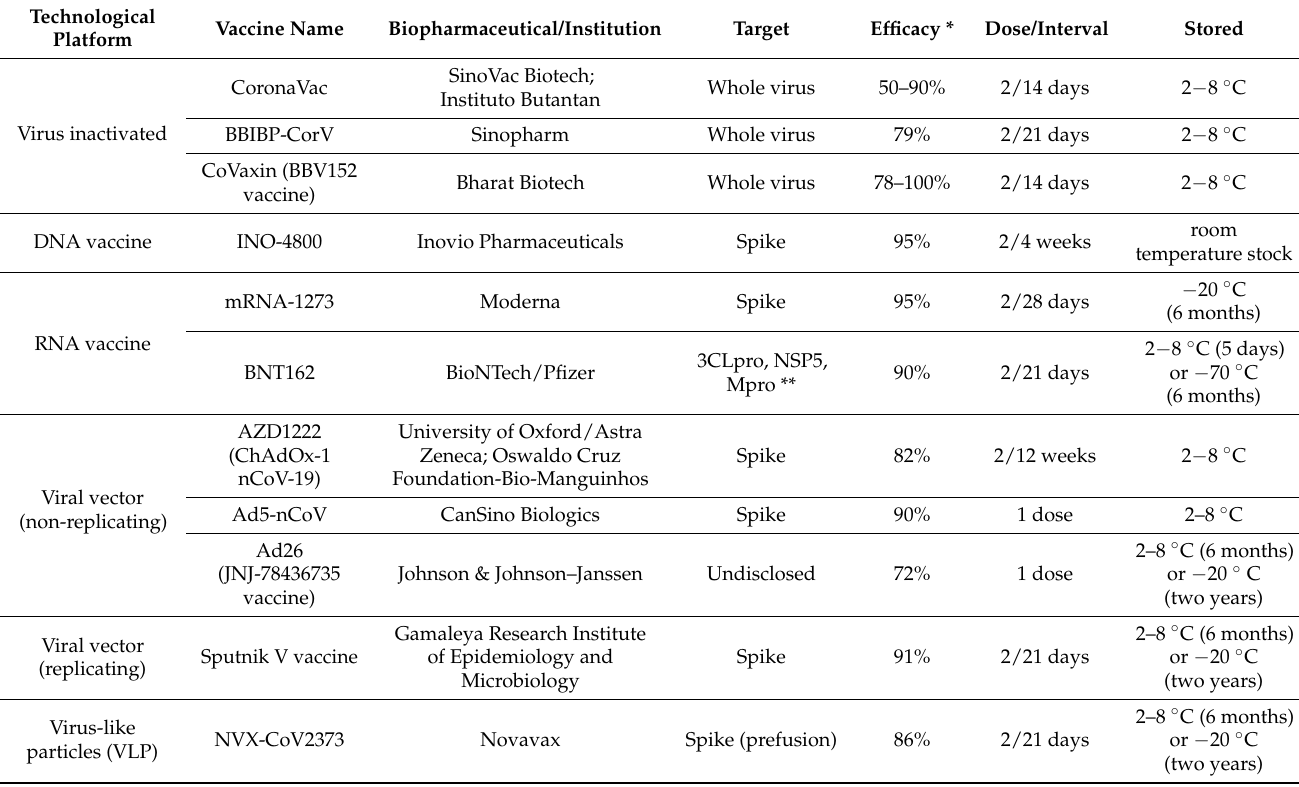
Table 9. Technological platforms for SARS-CoV-2 vaccine candidates licensed or under